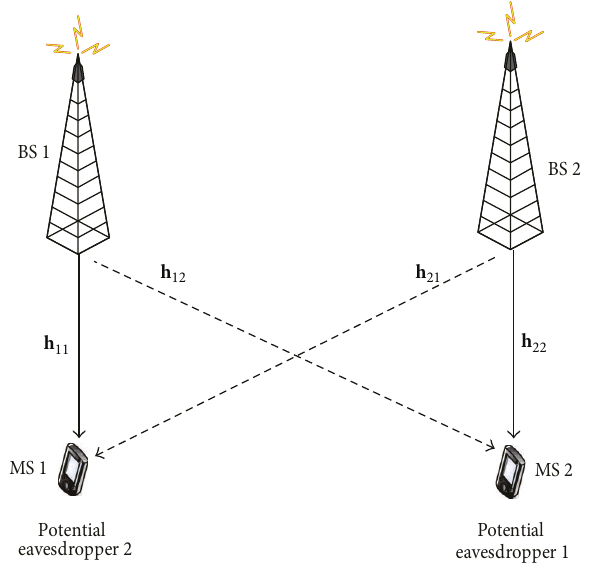
Figure 1: Coordinated beamforming with two BSs and two untrusted